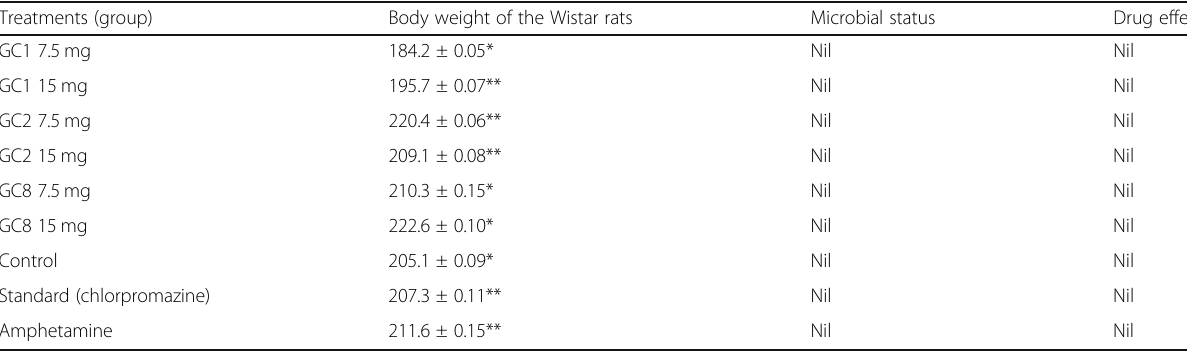
Table 2 Status of the animal ’ s health prior to the treatment Treatments (group)